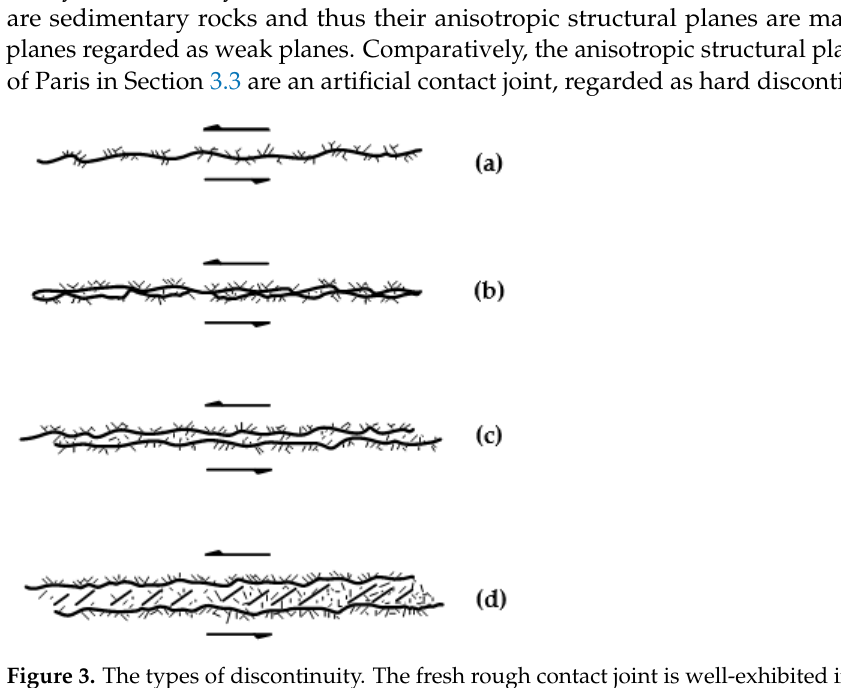
Figure 3. The types of discontinuity. The fresh rough contact joint is well-exhibited in ( a ), while the filled layer becomes thicker and thicker ( b – d ) denoting the soft discontinuous layer.